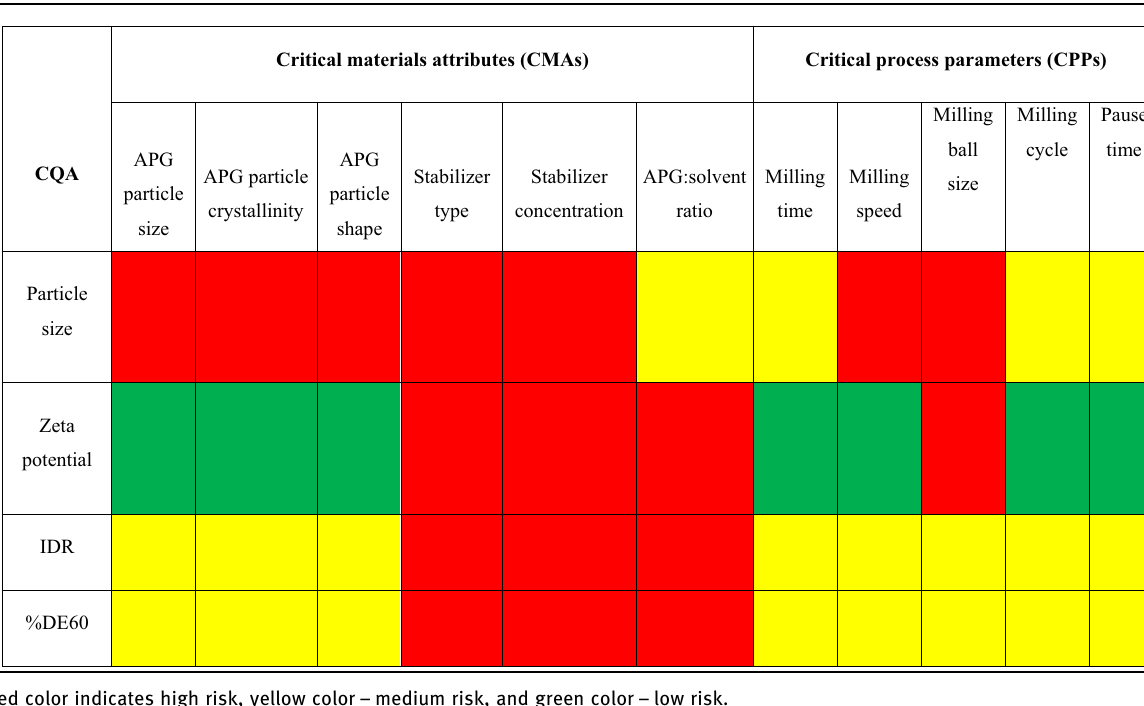
Table 5: Risk assessment of potential factors a ff ecting CQAs of APG nanoparticles prepared by planetary ball milling by PHA tool